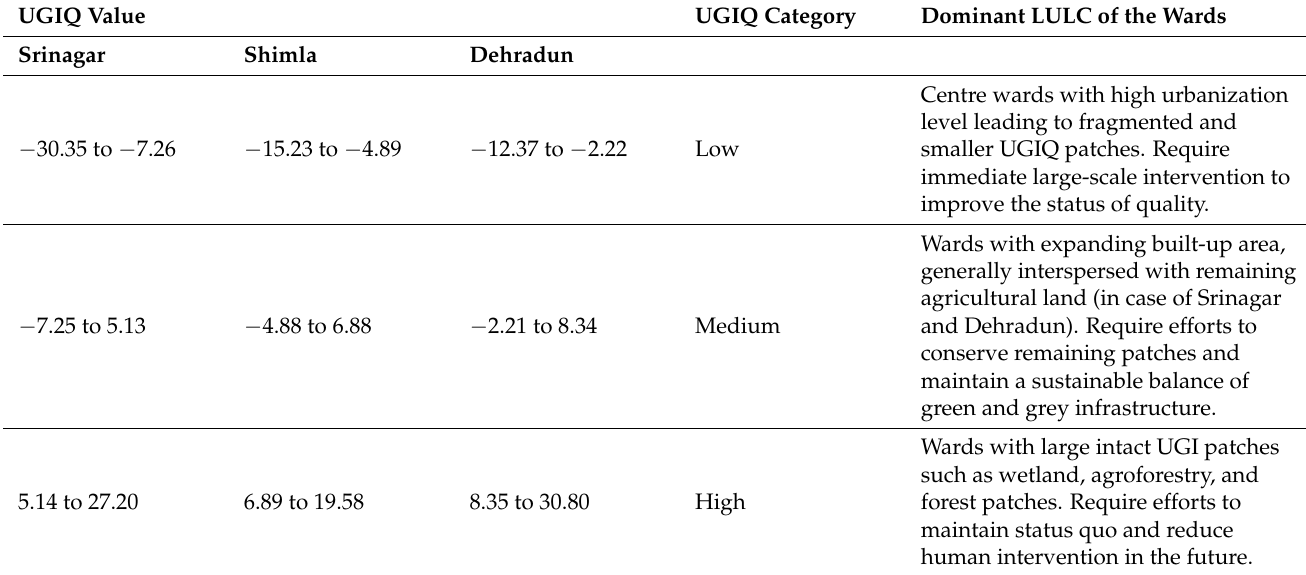
Table 4. UGIQ variation in categories across